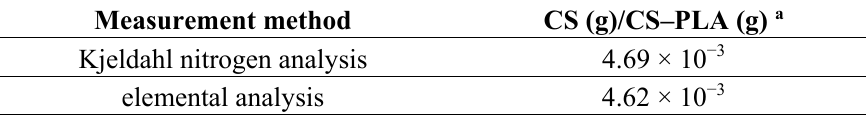
Table 2. Quantitative data of CS content in CS–PLA (P-3).